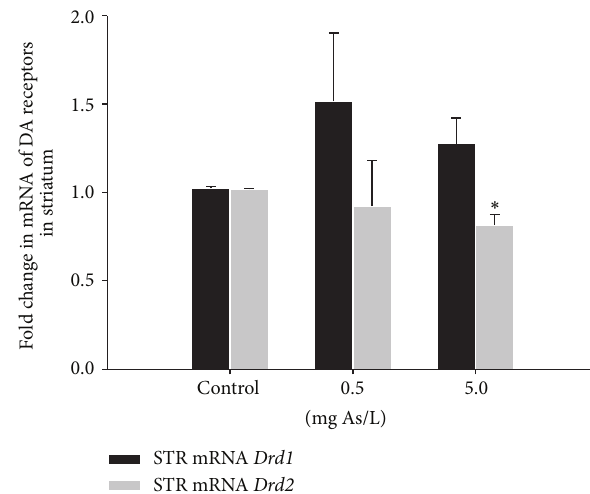
Figure 3: Dopamine receptors D1 ( Drd1 ) and D2 ( Drd2 ) mRNA expression in the striatum of male CD1 mice exposed chronically to 0.5 or 5.0 mg As/L of As in drinking water. Data was normalized to Bact and is presented as fold change relative to control group (mean ± SEM). ∗ denotes differences from the control group, 𝑝 <